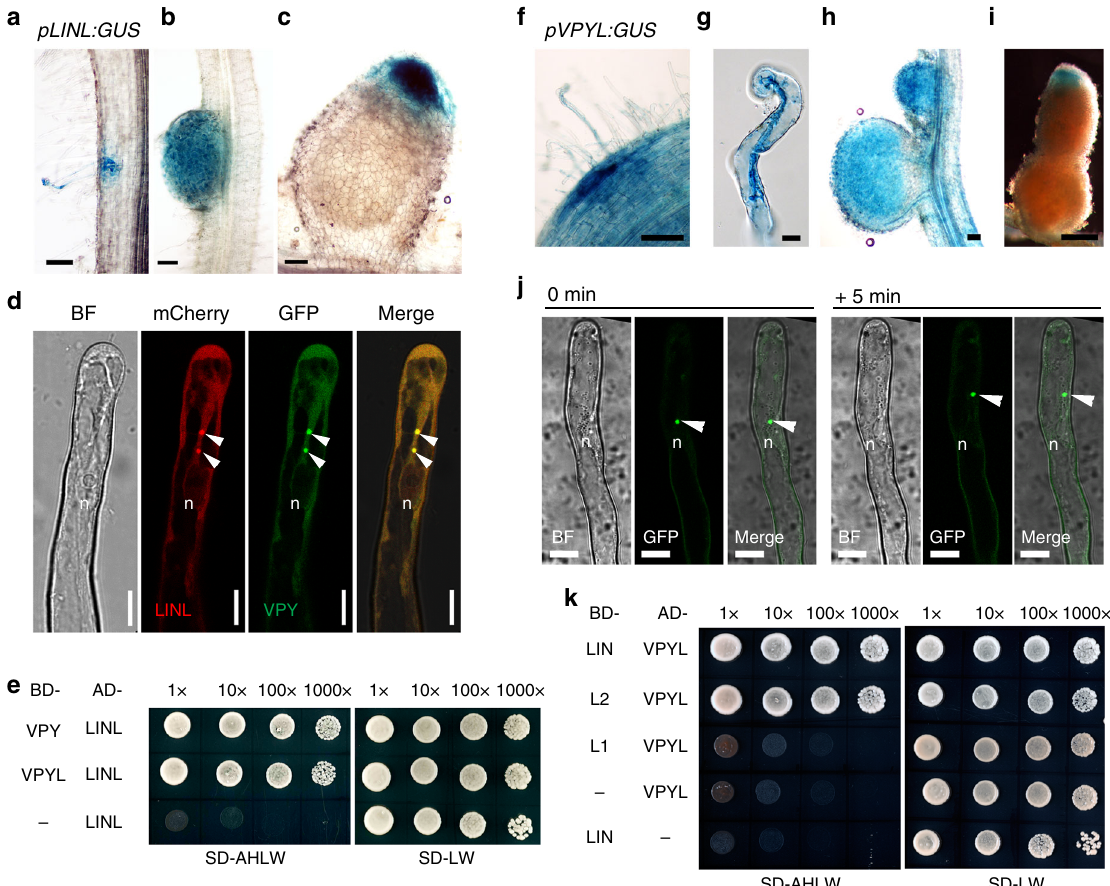
Fig. 8 A protein complex containing VPY, VPYL, LIN and LINL. a – c Expression of LINL in an infected root hair ( a ), in a young nodule ( b ) and in a mature nodule ( c ) as shown by pLINL:GUS activity. d Co-localization of VPY (green) and LINL (red) in root hairs of rhizobia-inoculated hairy roots transformed with pVPY:VPY-GFP / pLjUBQ1:mCherry-LINL . e Yeast two-hybrid assays between VPY, VPYL and LINL. f – i Expression of pVPYL:GUS at infection site ( f ), in a root hair harbouring an infection thread ( g ), young and mature nodules ( h , i ). j Live cell images of localization of GFP-VPYL driven by pLjUBQ1 promoter at two time points (0 min and 5 mins later) in a root hair after inoculation with rhizobia. k Yeast two-hybrid assays between VPYL and LIN, C terminus of LIN (L2) and N terminus of LIN (L1). BD, pGBKT7; AD, pGADT7. SD-LW, SD-Leu-Trp; SD-AHLW, SD-Ade-His-Leu-Trp. GUS staining were shown as blue. DsRED and GFP were pseudo coloured in red and green respectively. Arrowheads, GFP/mCherry puncta. n, nucleus. Scale bars, 100 µ m ( a – c , f, h , i ) and 10 µ m ( d , g and j